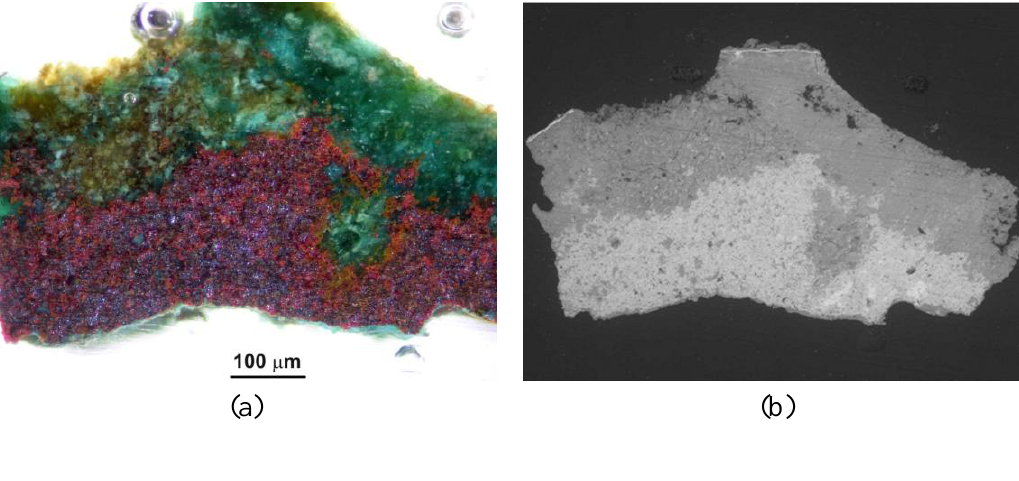
Figure 29. Exemplary images of the bow deposit cross section: (a) microscope photograph; (b) SEM. Scales are almost the